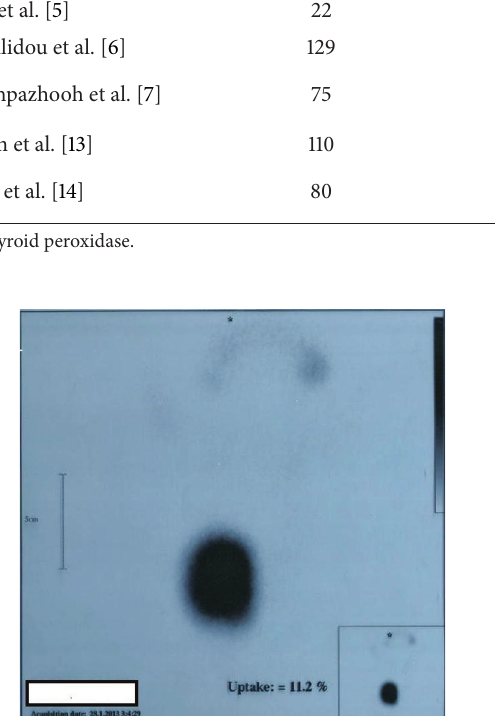
attached to the skin overlying or surrounding muscles. Both carotids are in place and are felt. No exophthalmos, tremors, or pretibial myxedema noted on examination. On the skin of the face, chest, abdomen, back, and extremities there were flaccid bullae, raw, and denuded erosions with affection of buccal